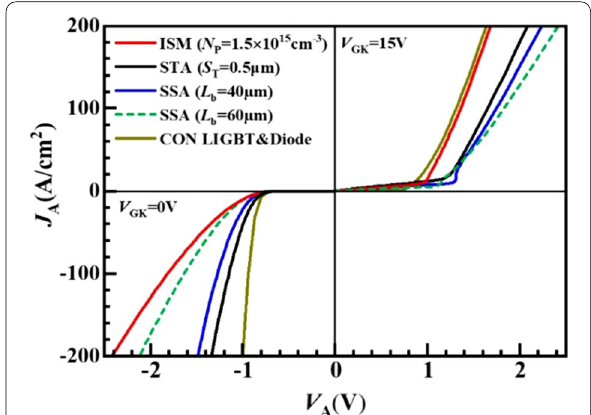
Fig. 5 Comparison of conduction characteristics for ISM, STA, SSA LIGBTs and Con. LIGBT& diode. S T is the spacing between the segmented trenches for the STA LIGBT. L b is the distance between N-buffer and separated N anode for the SSA LIGBT. For ISM device, + N